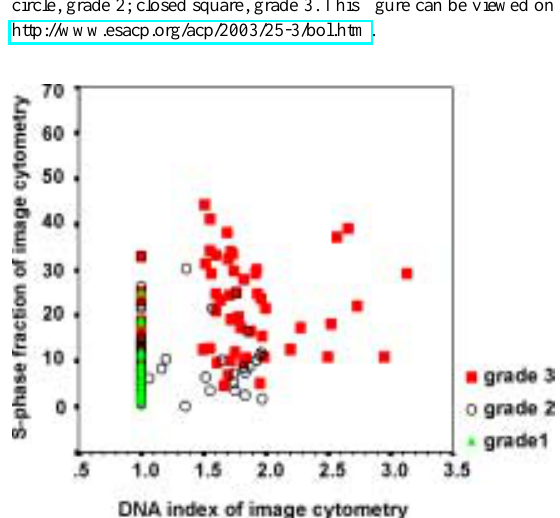
Fig. 4. Urothelial cell carcinomas (UCs). Scatterplot of S phase frac- tion (SPF) obtained by flow cytometry (FCM) and image cytometry (ICM) in 202